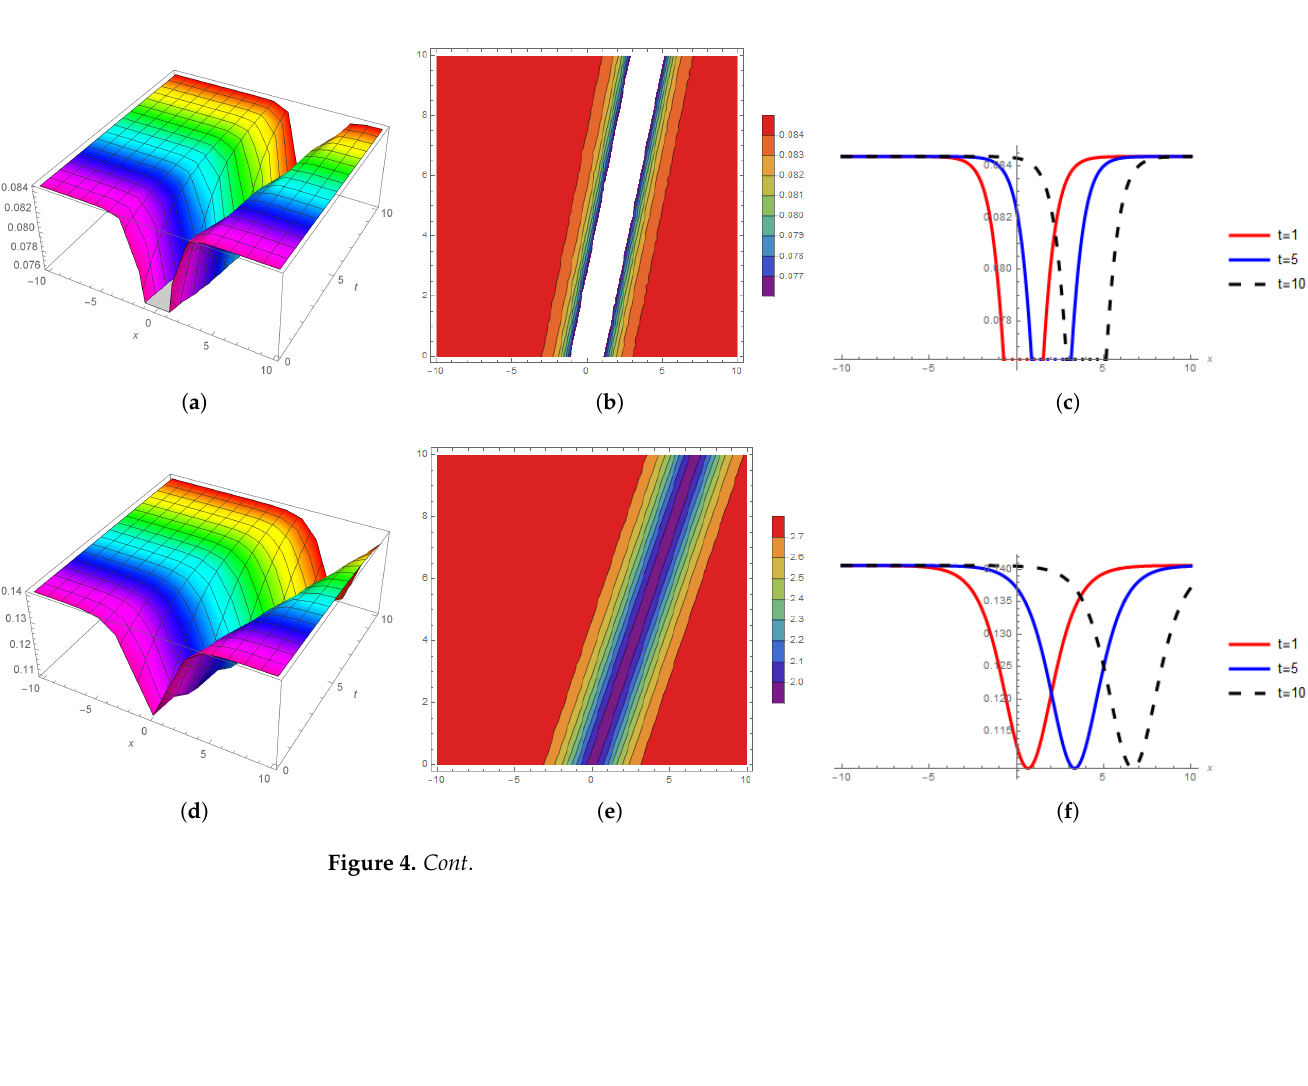
Figure 3. The 3D, contour, and 2D behavior comparison for U 1 ( ξ ) ; ( a ) 3D wave profile at wave number λ = 2.5; ( b ) contour wave profile at wave number λ = 2.5; ( c ) 2D wave profile at wave number λ = 2.5; ( d ) 3D wave profile at wave number λ = 1.5; ( e ) contour wave number soliton solution at λ = 1.5; ( f ) 2D wave profile at wave number λ = 1.5; ( g ) 3D wave profile at wave number λ = 0.5; ( h ) contour wave profile at wave number λ = 0.5; ( i ) 2D wave profile at wave number λ = 0.5.